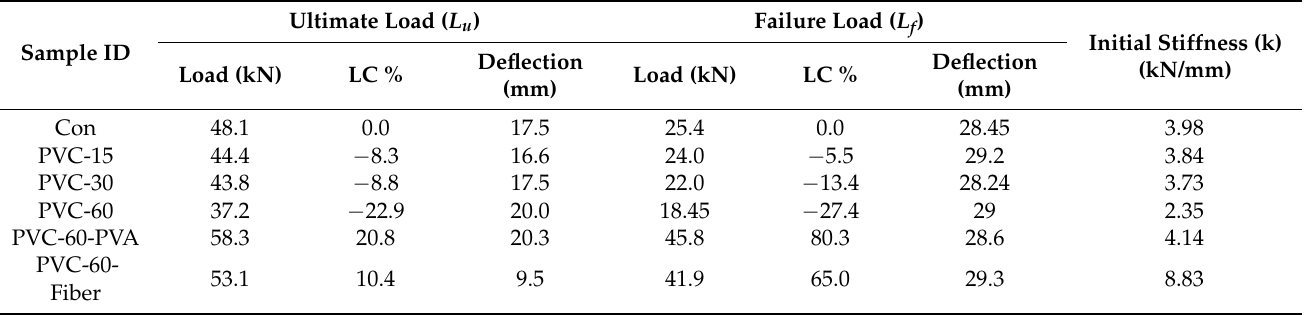
Table 7. Test Results of the Tested